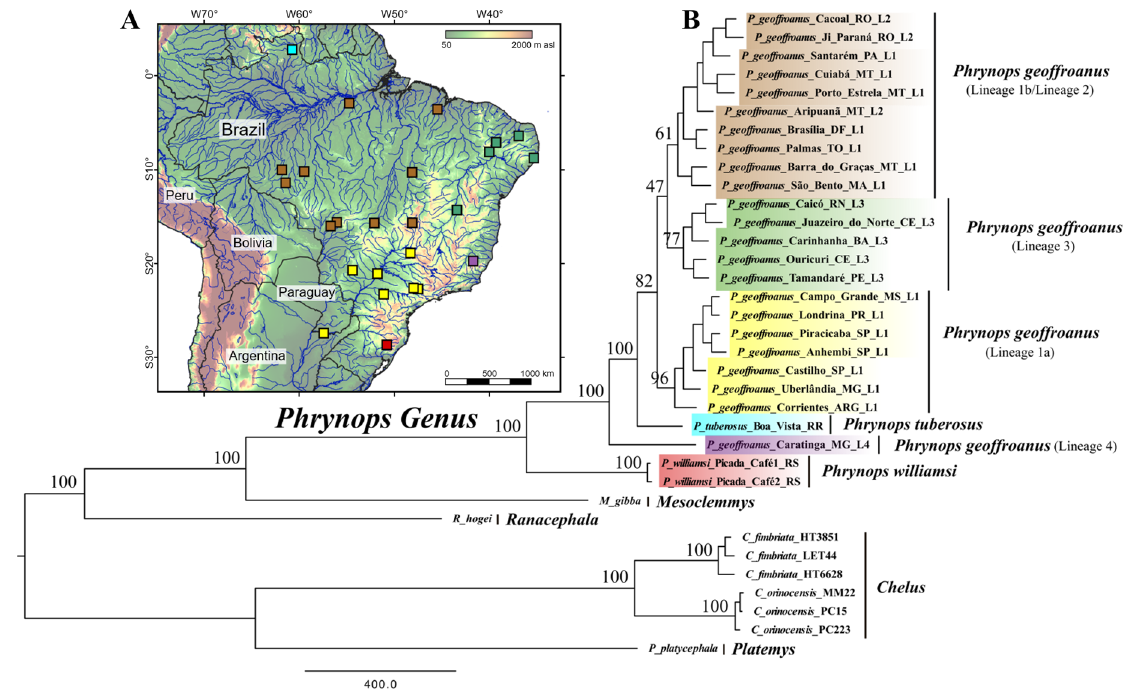
Figure 2. SDVquartet phylogeny of SNP data. Numbers above branches are bootstrap values. ( A ) Ge- ographic distribution of lineages. ( B ) Maximum clade credibility chronogram from 1000 posterior trees generated using